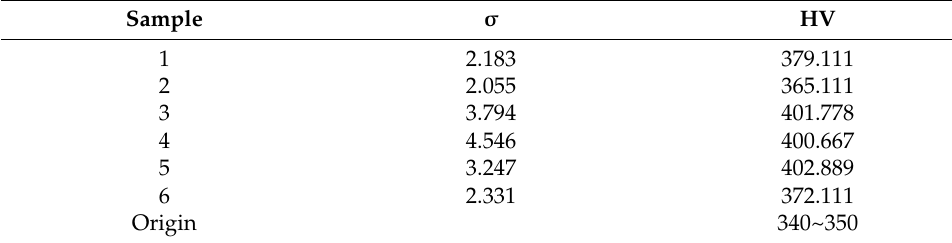
Table 9. Overall hardness for each